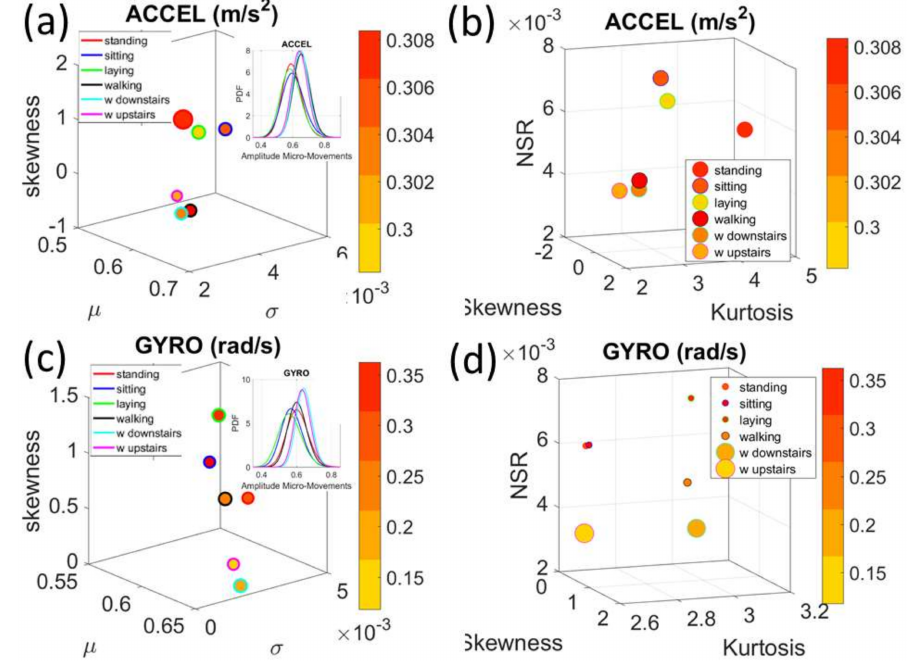
Figure 7. Comparison of acceleration and gyro signatures for the summary (group) data set involving the mean values of fluctuations in peak-amplitude. ( a ) Separation into two general types of activities (walking related and resting related) are congruent with the individual subjects’ data. ( b ) Separation is also evident for the higher Gamma moments. ( c , d ) Gyro data separates but does not show a clear cut pattern as the accelerometer